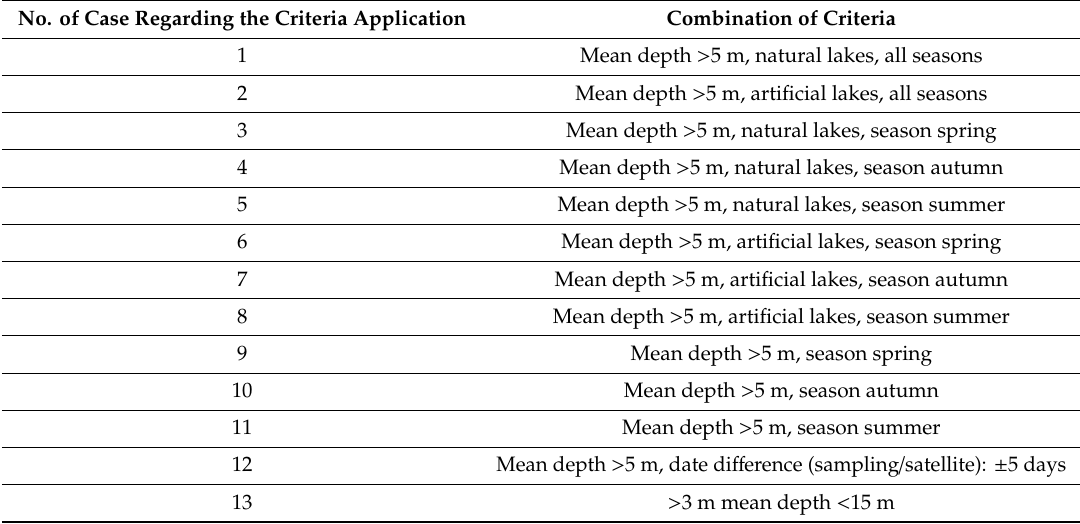
Table 8. Description of cases including all possible combinations of criteria applied. The criteria were selected according to principal component analysis (PCA)